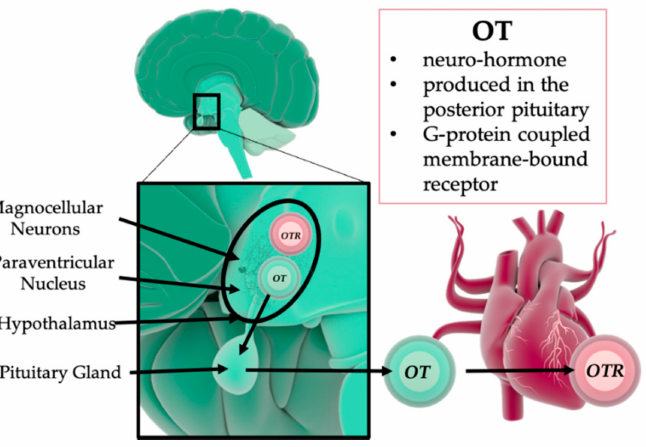
Figure 1. Oxytocin (OT) production and release. The neuro-hormone OT is produced within the magnocellular neurons of the hypothalamus and paraventricular nucleus (PVN). From the posterior lobe of the pituitary gland, OT is released into the circulation, where it acts via the G-protein-coupled oxytocin receptor (OTR). OT: oxytocin; OTR: oxytocin receptor; PVN: paraventricular nucleus. Illustrations of the heart, brain, and the circle shapes (spheres) were taken from the Library of Science and Medical Illustrations (somersault18:24,